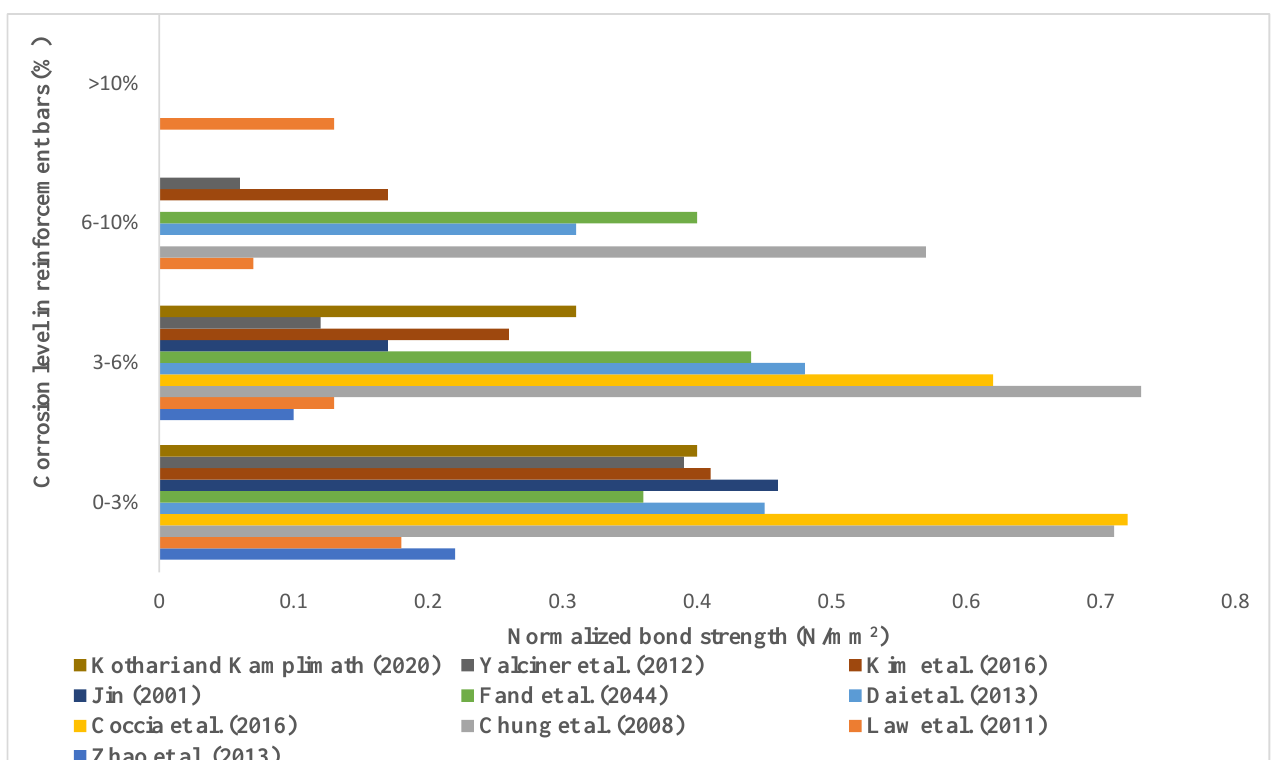
Figure 8. It can be observed that bond strength is higher for corrosion rates of less than 6% when compared to the higher corrosion rates of steel bars.